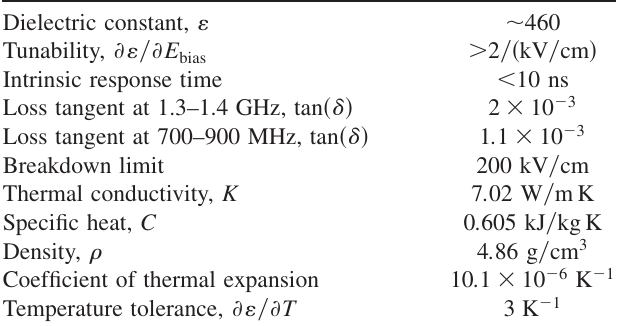
TABLE I. Properties of modified BST ferroelectric ceramic. Dielectric constant,